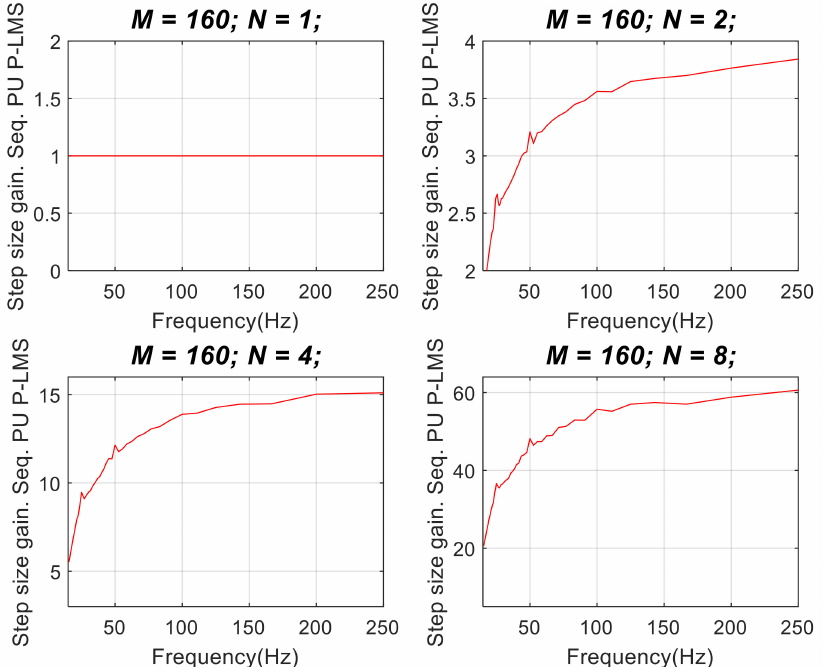
Figure 5. Gain in step-size for a single tone when using the matrix-based version (from Parra et al.) of the periodic LMS algorithm with seq. partial updates. The length of the filter is set to 160 taps. The decimation factor takes values 1, 2, 4 and